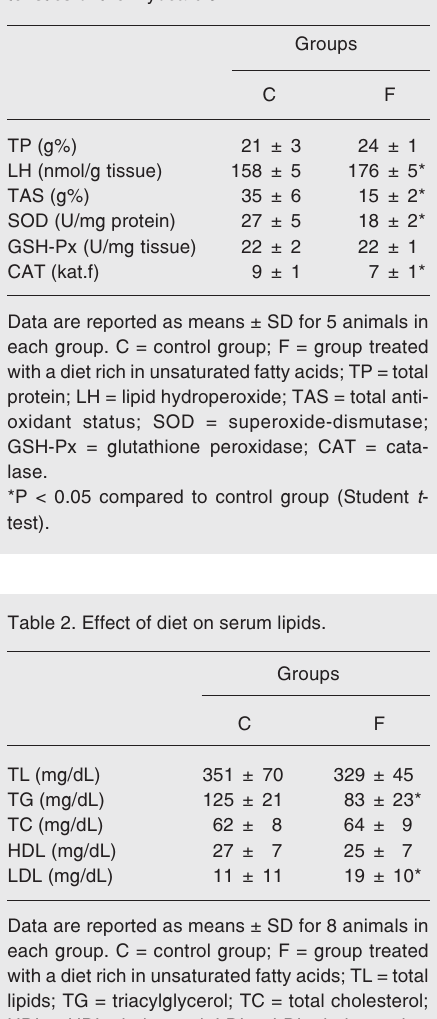
Table 1. Effect of diet on the biochemical charac- teristics of the myocardium.